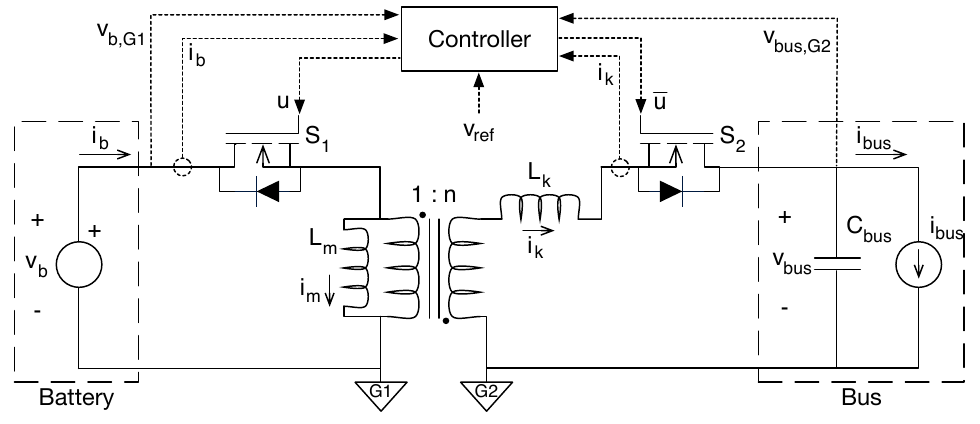
Figure 1. Circuital implementation of the battery